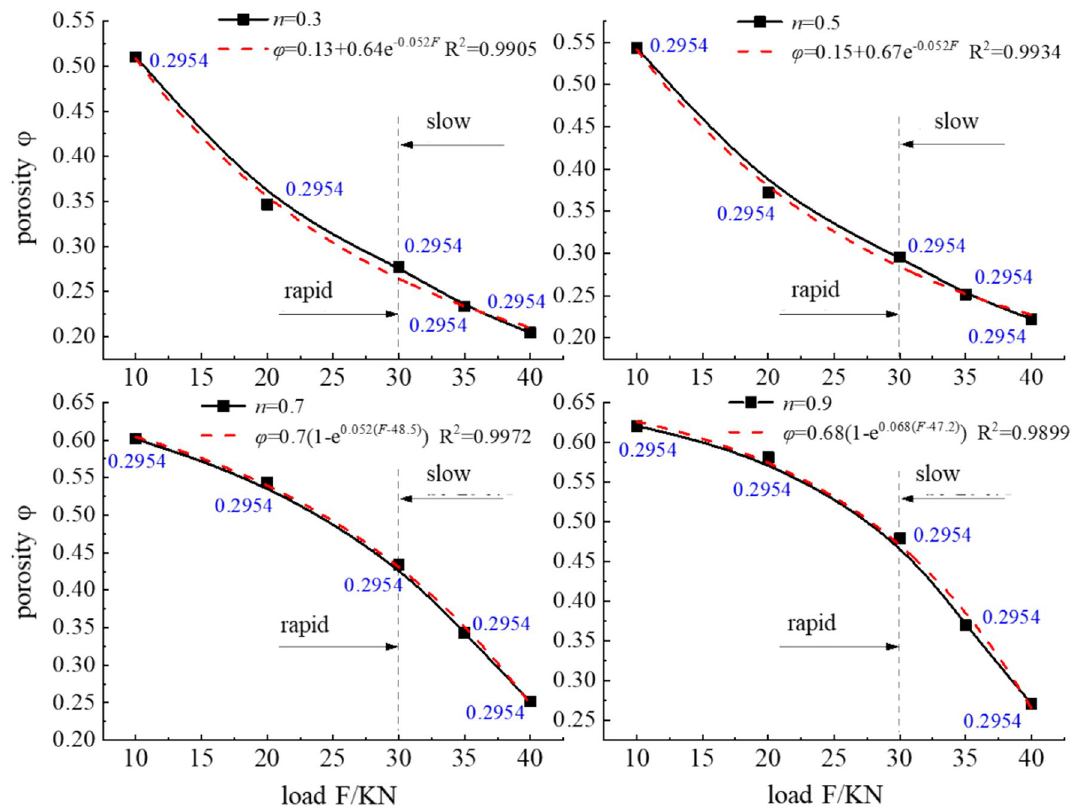
Figure 6. Relationship between the porosity changes under the different